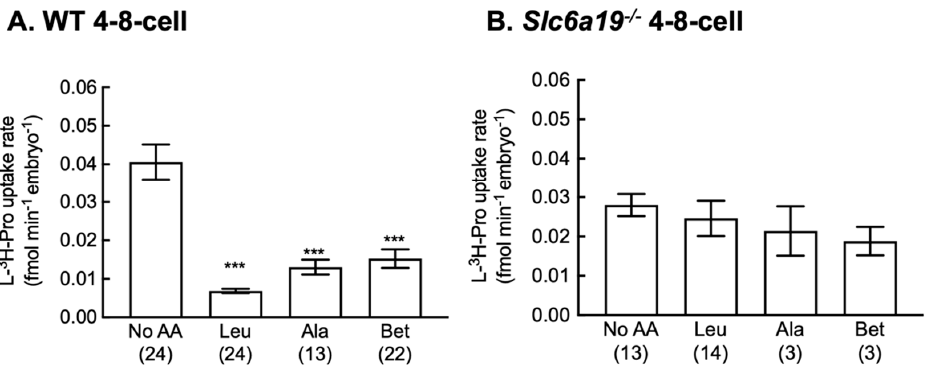
Figure 5. Characteristics of AA transport are different in embryos obtained from Slc16a19 − / − mice compared to embryos from WT mice. Rate of uptake of L-[ 3 H]-Pro was measured in 4–8-cell stage embryos from ( A ) WT or ( B ) Slc6a19 − / − mice without (No AA) or with molar excess (5 mM) of unlabelled AAs. Each bar represents the mean ± SEM with the number of replicates given in parentheses. Each replicate was performed on 1–4 embryos over at least 3 independent experiments. Data were analysed using one-way ANOVA with Dunnett’s post hoc test. *** p < 0.001 compared to No AA. Bet = betaine, Leu = leucine, Ala = alanine. Note that bars for No AA and Pro in this figure are the same data as in Figure 4.